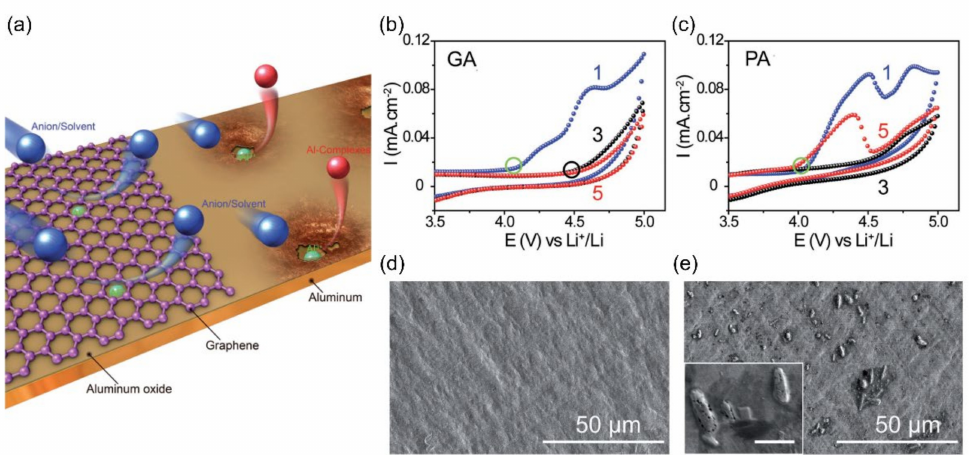
Figure 15. ( a ) Schematic illustration of graphene-armored aluminum foil with enhanced anti-corrosion property as current collectors for Li-ion batteries. CV curves of ( b ) the graphene-coated and ( c ) pristine Al current collectors in LPF 6 electrolyte, and the number denotes the cycle index. SEM micrographs of ( d ) the graphene-coated and ( e ) pristine Al current collectors after cyclic voltammetry scanning for 5 cycles in the LiPF 6 -based carbonate electrolyte. Reproduced with permission from ref. [177]. Copyright 2017,